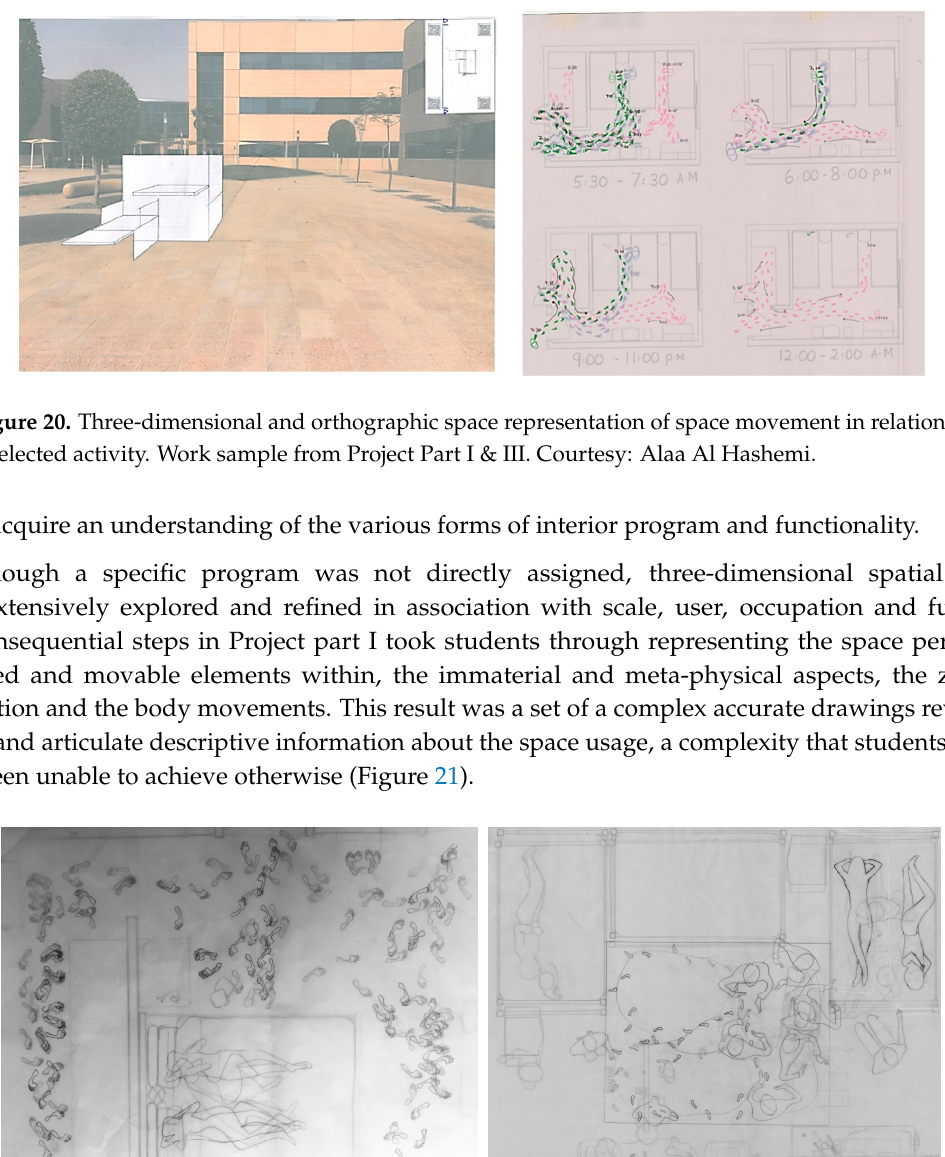
Figure 21. Layered drawings compromised of the five prescribed steps. Work sample from Project Part I. Courtesy: Mariam Al Nuaimi and Alaa Al Hashemi.